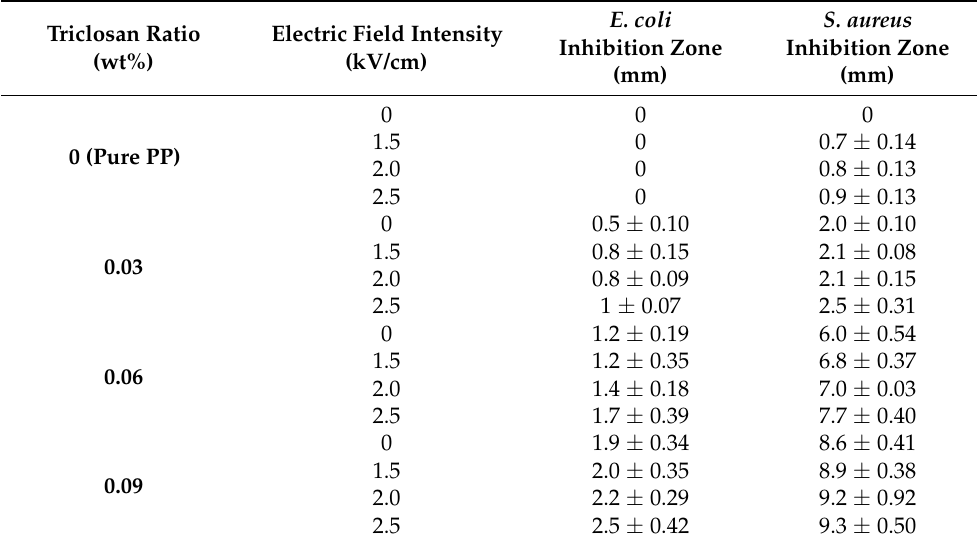
Table 2. Effects of triclosan amount (0, 0.03, 0.06, and 0.09 wt%) and electric field intensity (1.5, 2.0, and 2.5 kV/cm) on inhibition zone against E. coli and S. aureus